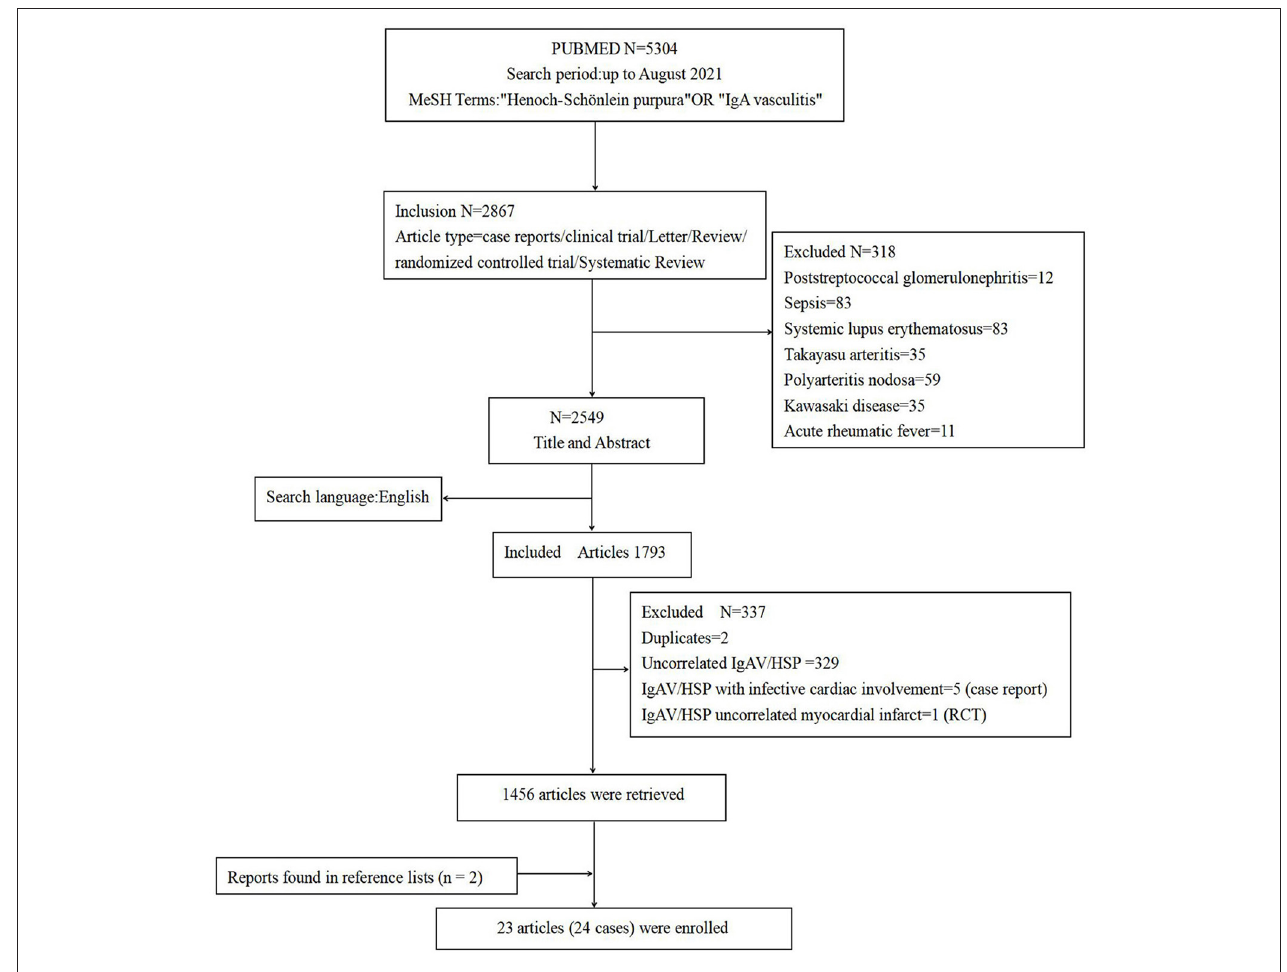
FIGURE 3 | Flowchart of the literature search.